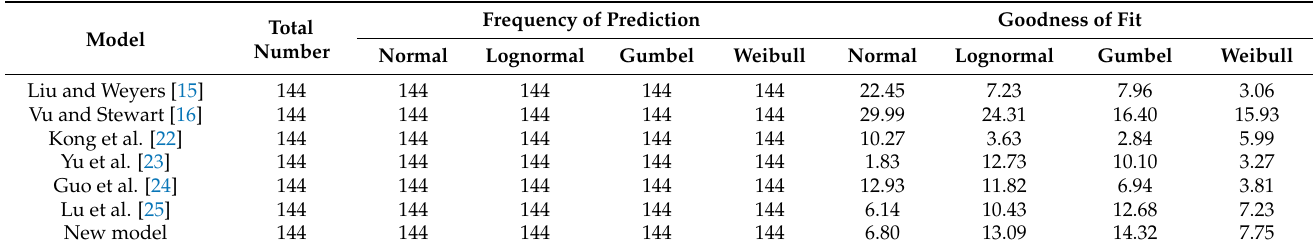
Table 5. Experimental values/calculated values of Chi-square test results.